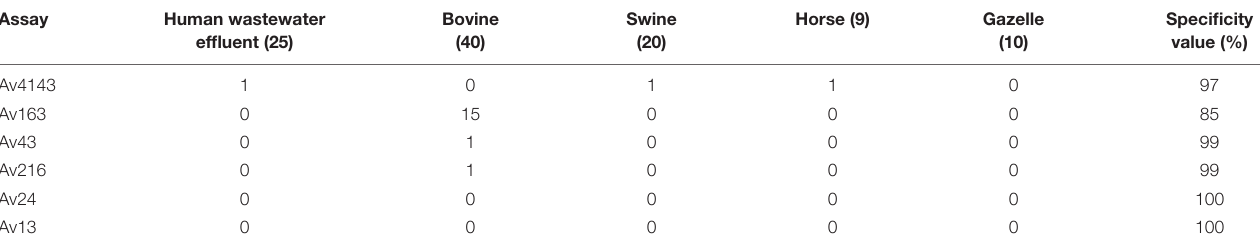
Assay Human wastewater